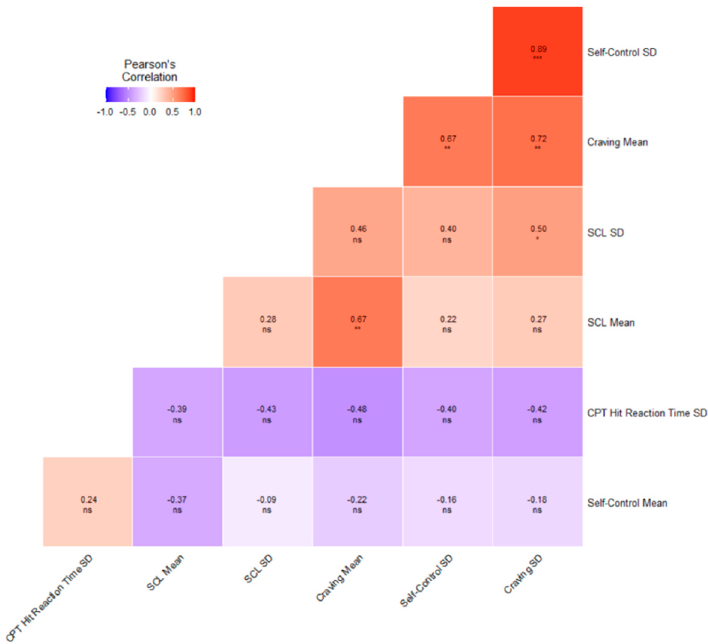
Figure 1. The Pearson product–moment correlation coefficients between the repeated measures summary scores and baseline variability in reaction time (CPT.HRT.SD) among the predictor variables. The mean and standard deviations for the repeated measures variables were calculated across occasions for each participant. The CPT HRT SD was measured once at the baseline. SCL—Hopkins Symptom Check-list 5 item version, CPT HRT SD—Conners Continuous performance test 3rd version, standard deviation of hit reaction time. Note: NS = No significance; Symbols *, **, and *** denote the significance levels at p < 0.05, p < 0.01, and p < 0.001, respectively, within-subject analyses.